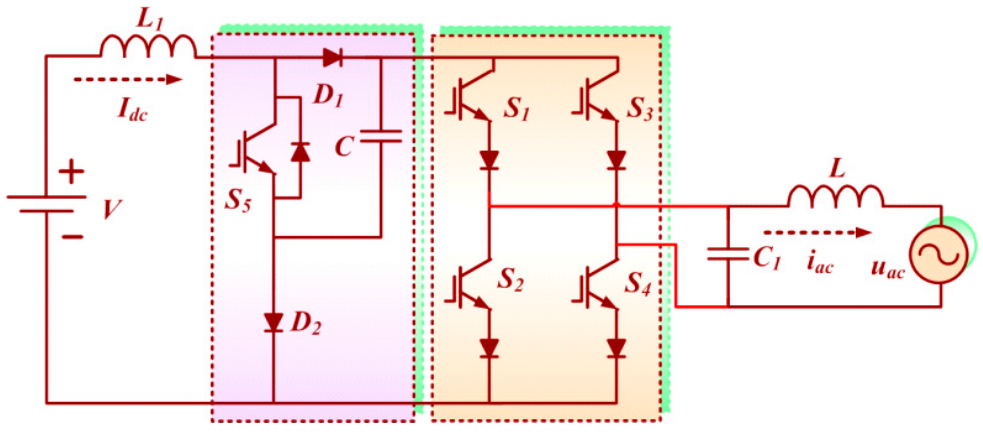
Figure 6. Power decoupling solution in [33].